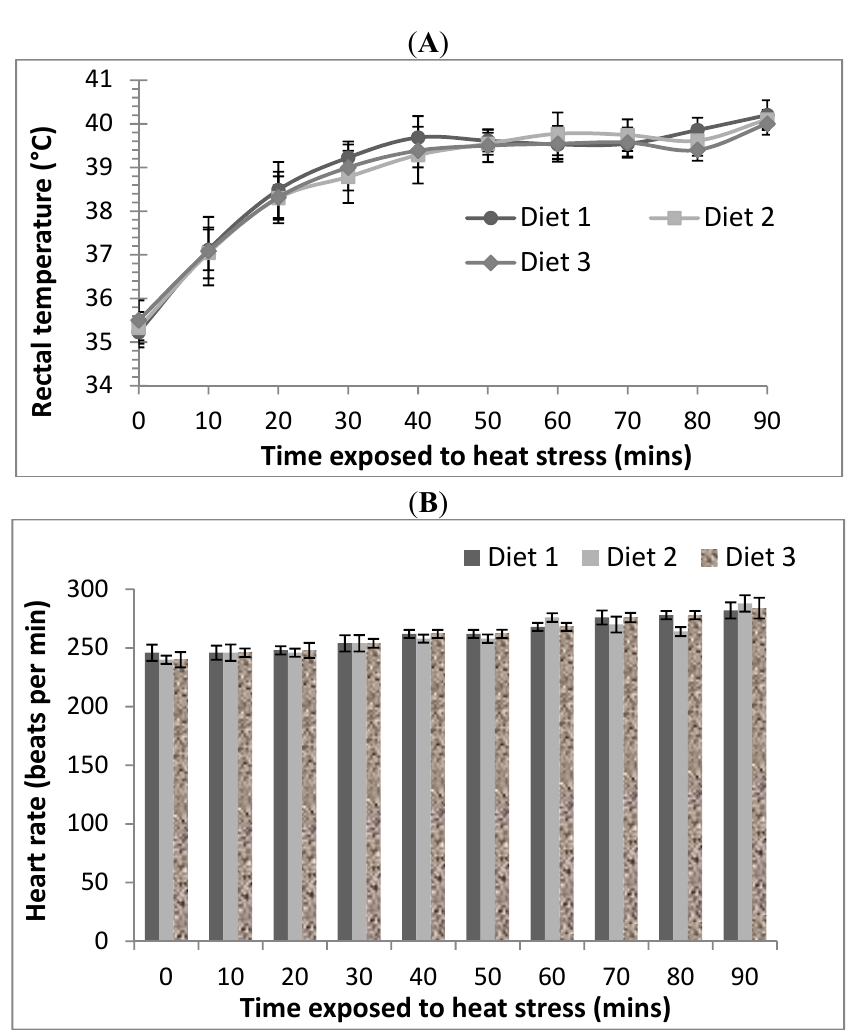
Figure 1 . Rectal temperatures ( A ) and heart rates ( B ) of rats over time period of exposure to heat stress conditions at 40 °C and 21% RH. Mean value and standard deviation of rectal temperature of rats and heart rates from Diet 1 ( n = 7), Diet 2 ( n = 7) and Diet 3 ( n = 7) were